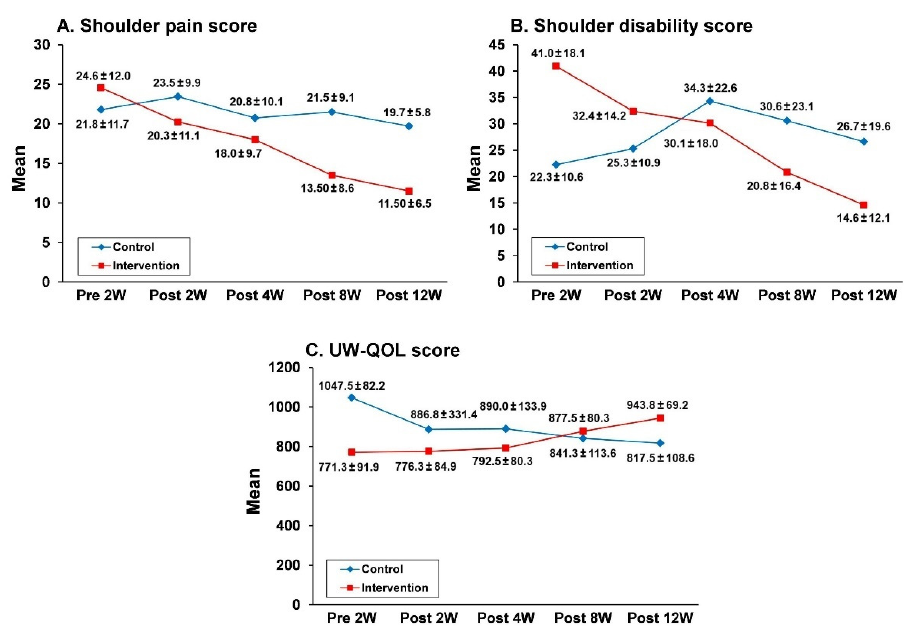
Figure 2. Changes in mean scores for shoulder pain ( A ), shoulder disability ( B ), and UW-QOL ( C ) over time during the study period. Mean scores were expressed as absolute values. UW-QOL, University of Washington Quality of Life Questionnaire. Post 2W, 4W, 8W, and 12W represent assessments at 2, 4, 8, and 12 weeks after surgery, respectively.